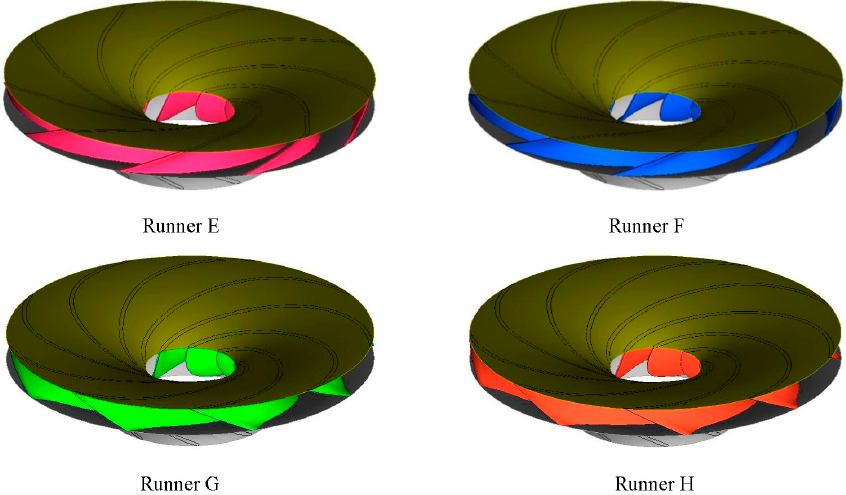
Figure 13. Geometry comparison for runners